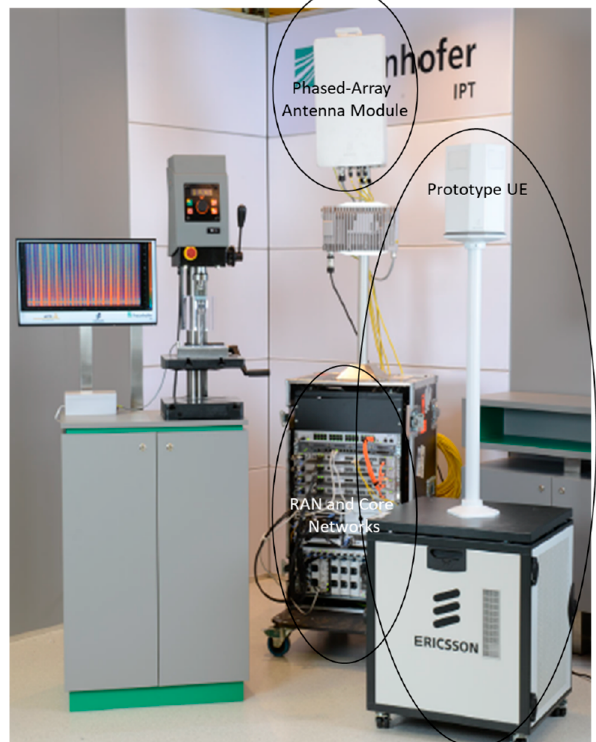
Figure 2. Selected parts of the URLLC testbed. The middle rack includes the RAN and core network with a phased-array antenna module on top. On the far right, the UE prototype is visible also with an antenna mounted on top.